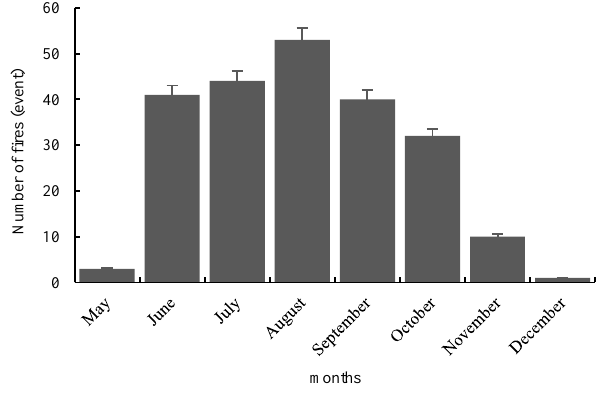
Figure 5 : The fires Frequency in the dry months from 2011 to 2020 The fires regularity in different components of natural resources presents that the highest and the least incidence includes non-wooded pastures (44.6±5.6) and mixed Forest-rangeland (14.25±4.11). The highest fires incidence in non-wooded pastures was in 2014, which includes almost 55%. In addition, the highest fire regularity on mixed forest-rangeland occurred in 2013, which includes virtually 20% (Table